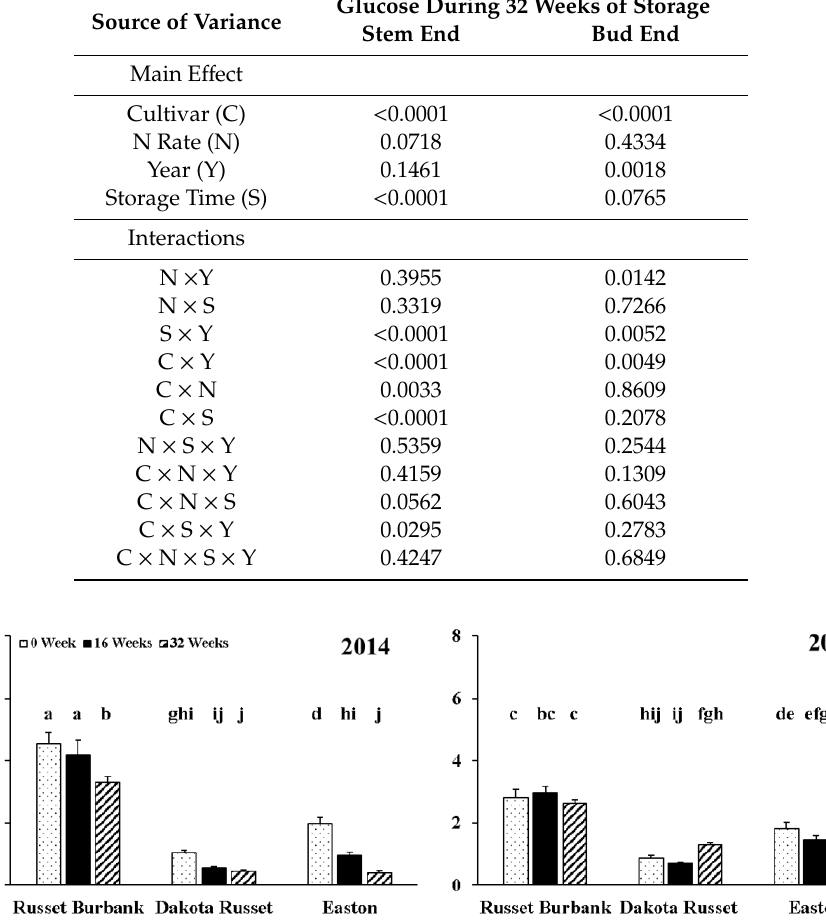
Table 1. The analysis of variance for glucose concentration during 32 weeks of storage in 2014 and 2015.